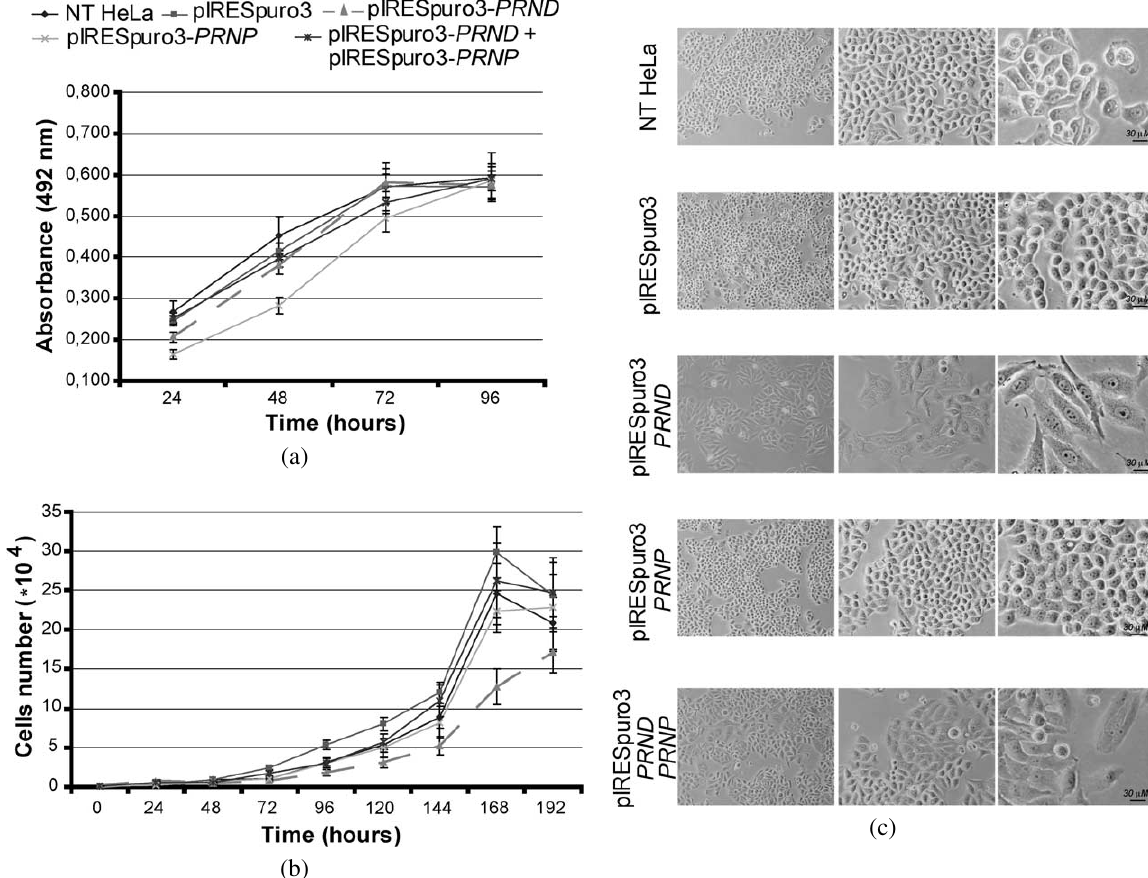
Fig. 4. Growth, viability assays and morphology evaluations. (a) An MTS-based assay was performed to evaluate the cellular viability. Ab- sorbance readouts at 492 nm, evaluated at 24, 48, 72 and 96 h time intervals, revealed a similar behaviour among overexpressing Dpl (pIRE- Spuro3- PRND ), PrP C (pIRESpuro3- PRNP ), both Dpl and PrP C (pIRESpuro3- PRND + pIRESpuro3- PRNP ), empty vector transfectants (pIRE- Spuro3) and untreated cells (NT HeLa). (b) The growth curves of the cells (evaluated for a 192 h time course) were analyzed; Dpl overexpressing cells show a lower plateau threshold compared to other cells. (c) Morphological analysis of HeLa cells, at 10 × , 20 × and 40 × magnifications respectively, show relevant alterations in the cellular shape: the typical squared shape of HeLa cells changes towards a lengthened forms in Dpl- and Dpl/PrP C -expressing cells. Scale bars are reported (30